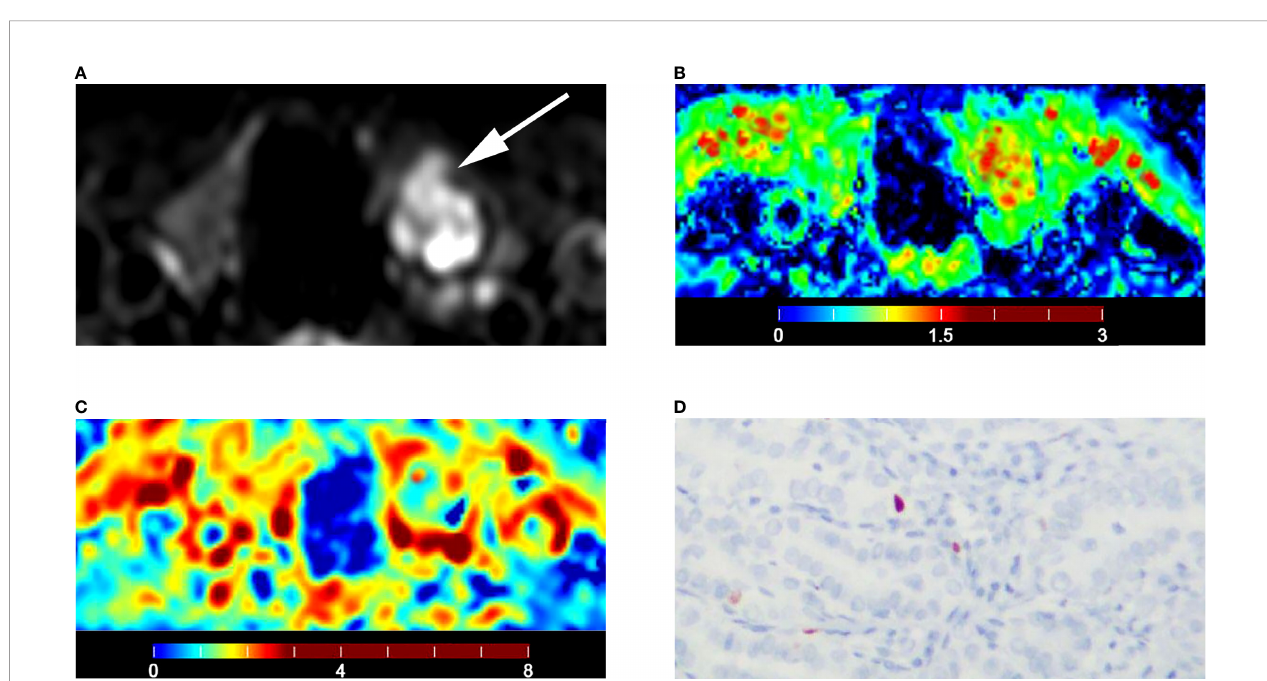
FIGURE 6 | Images of a 55-year-old male with left lobe papillary carcinoma (A-D): (A) axial diffusion image with b = 0; (B) color map of D, D value of lesion is 1.06 × 10 -3 mm 2 /s; (C) color map of D app , D app value of lesion is 1.43 × 10 -3 mm 2 /s; (D) Ki-67 expression is 1% in tumor